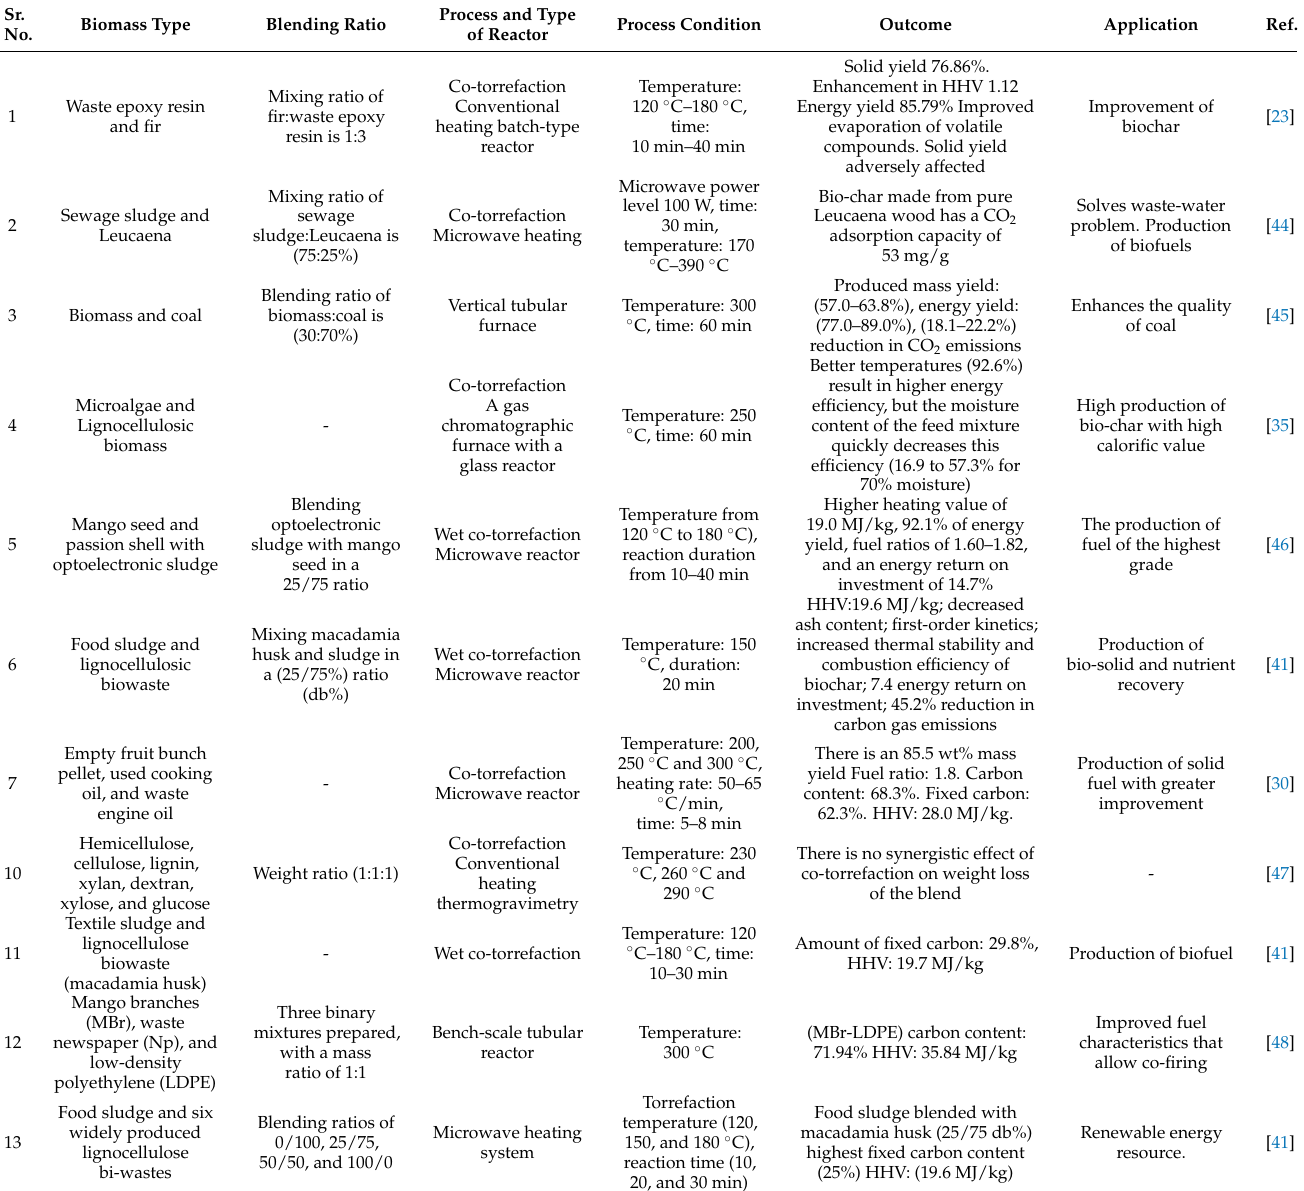
Table 1. Latest developments in the co-torrefaction